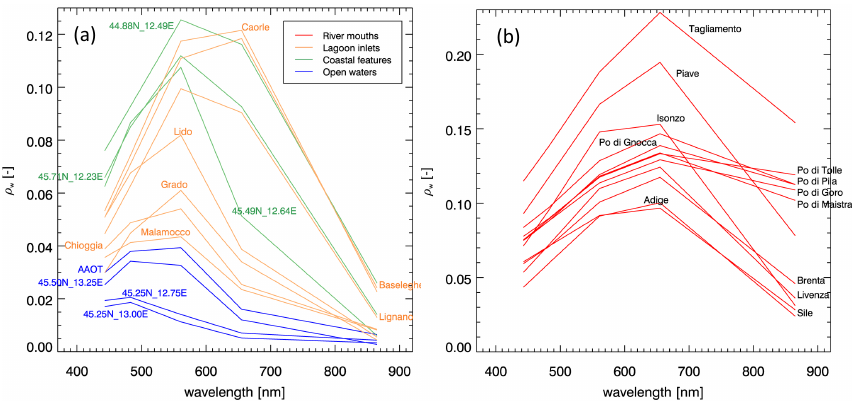
Figure 4. Reflectance spectra extracted from selected locations in NAS, including open waters, coastal features, lagoon inlets (a) , and river mouths (b)